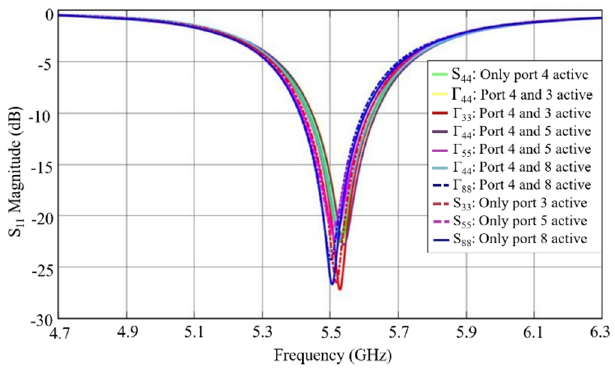
Figure 5. Simulations to evaluate the mutual coupling between 3D antenna elements.